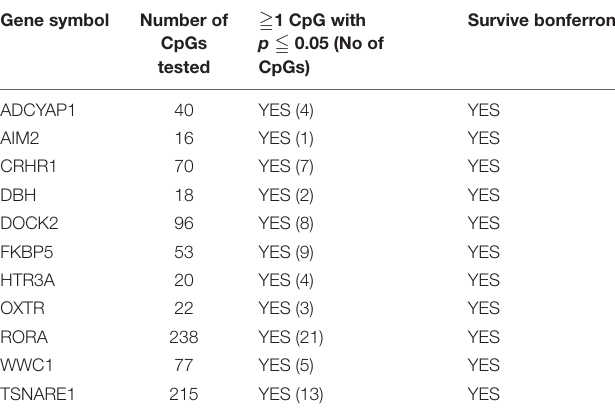
TABLE 4 | PTSD Candidate genes also associated with migraine in MZ twins with at least one Bonferroni significant CpG site. Gene symbol